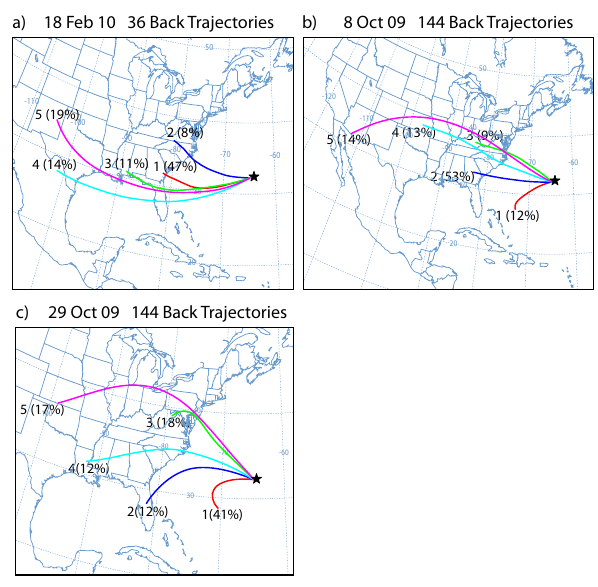
Fig. 2. (a–c) . Cold season 36h back trajectories for the three cold season rain events clustered from 100m, 2000m, and 5000m start- ing every hour during the rain event as in Fig.